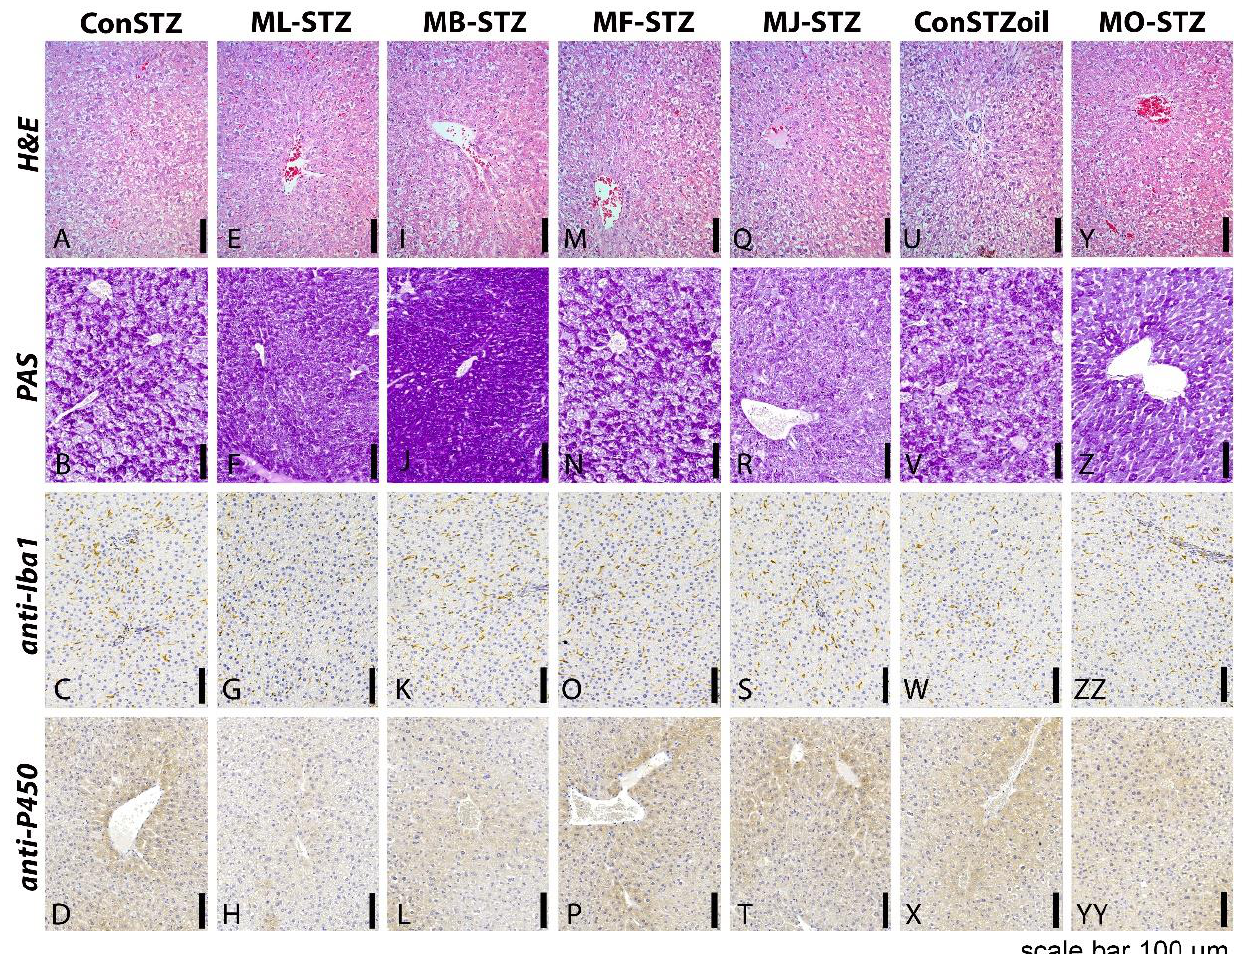
Figure 8. Histopathology analysis of the effects of black mulberry extracts in streptozotocin-induced liver injury (ConSTZ — saline 10 mL/kg; ConSTZOil — olive oil 10 mL/kg; ML-STZ — black mulberry leaf ethanol extract; MB-STZ — black mulberry bark ethanol extract; MF-STZ — black mulberry fruit ethanol extract; MJ-STZ — black mulberry juice; MO-STZ — black mulberry seed oil). H&E ( A – Y ), PAS ( B – Z ); anti-Iba1 ( C – ZZ ); anti-P450 ( D – YY ); magnification 200×; scale bar 100 µm.